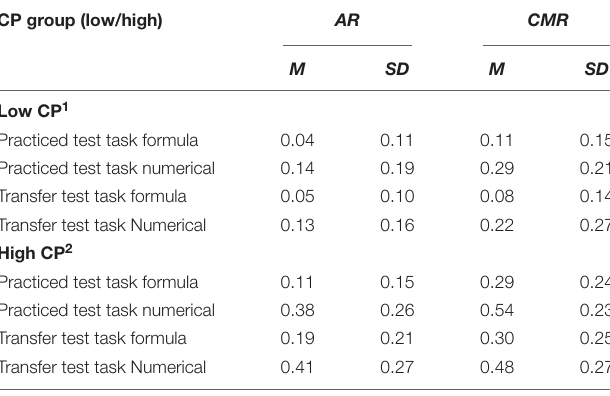
TABLE 1B | Mean proportion correct response ( M ) and standard deviations ( SD ) for AR and CMR learning conditions across low and high CP groups. CP group (low/high)